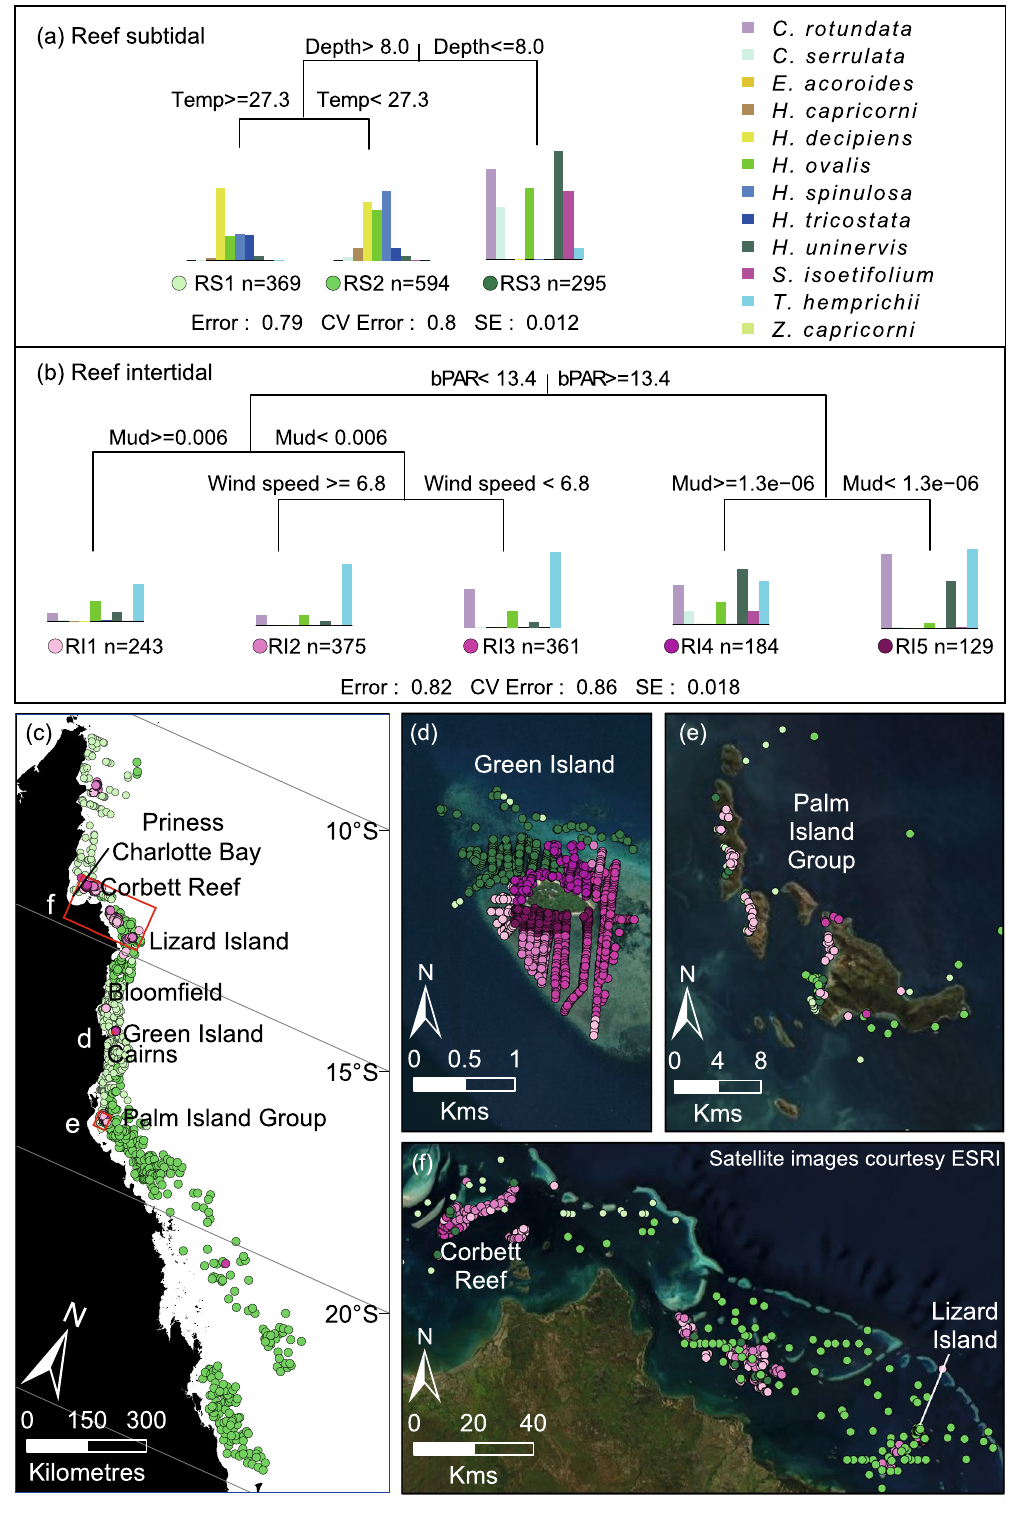
Figure 7. Multivariate regression tree (MRT) and seagrass communities classified for reef waters using species presence/ absence data for ( a ) subtidal sites and ( b ) intertidal sites. The number (n) below each community is the count of observations that fall into that community. The histogram shows the frequency of occurrence for each species in that community with the height of the bar representing the frequency that each species was observed in that assemblage. The coloured dots represent unique communities for reef intertidal (RI) 1–5, and reef subtidal (RS) 1–3. The CV Error is the cross-validated relative error. ( c ) The spatial distribution of communities across the Great Barrier Reef World Heritage Area (red border), and ( d – f ) finer-scale maps of communities at select locations. Map created using ArcGIS software version 10.8 by Esri (www. esri. com). Satellite image copyright